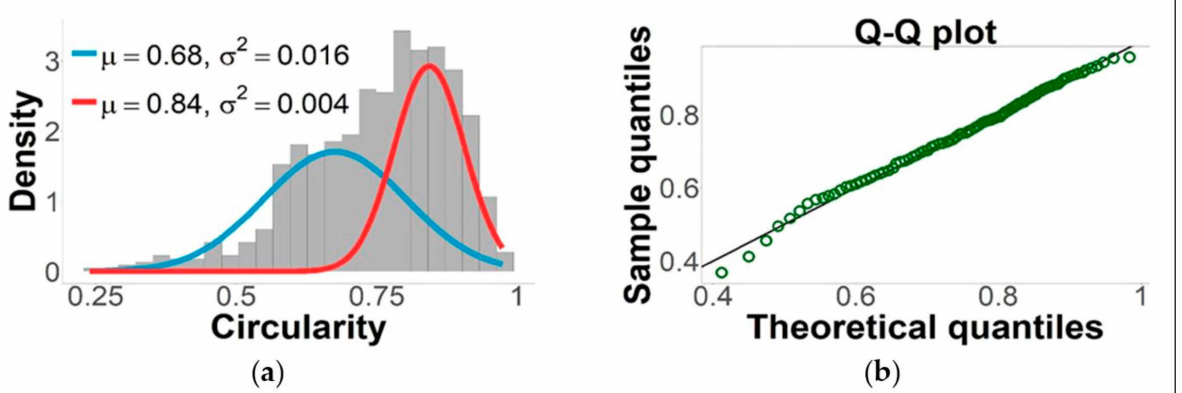
Figure A9. ( a ) A histogram of the circularity values of the total number of 706 individual cells examined in TECs collected after 1 week of in vitro culture. The data are best described by two normal distributions (blue and red curves represent probability density functions) and reveal the formation of two subpopulations of cancer cells with different circularities such as elongated oval-shaped “mesenchymal-like” and nearly circular-shaped “epithelioid” cells with circularity values of ~0.68 and ~0.84, respectively. ( b ) Comparison between the quantiles of the theoretical bimodal normal distribution with the quantiles of the observed data. The data points are positioned close to y = x, indicating that the distribution of the sample data is similar to the normal